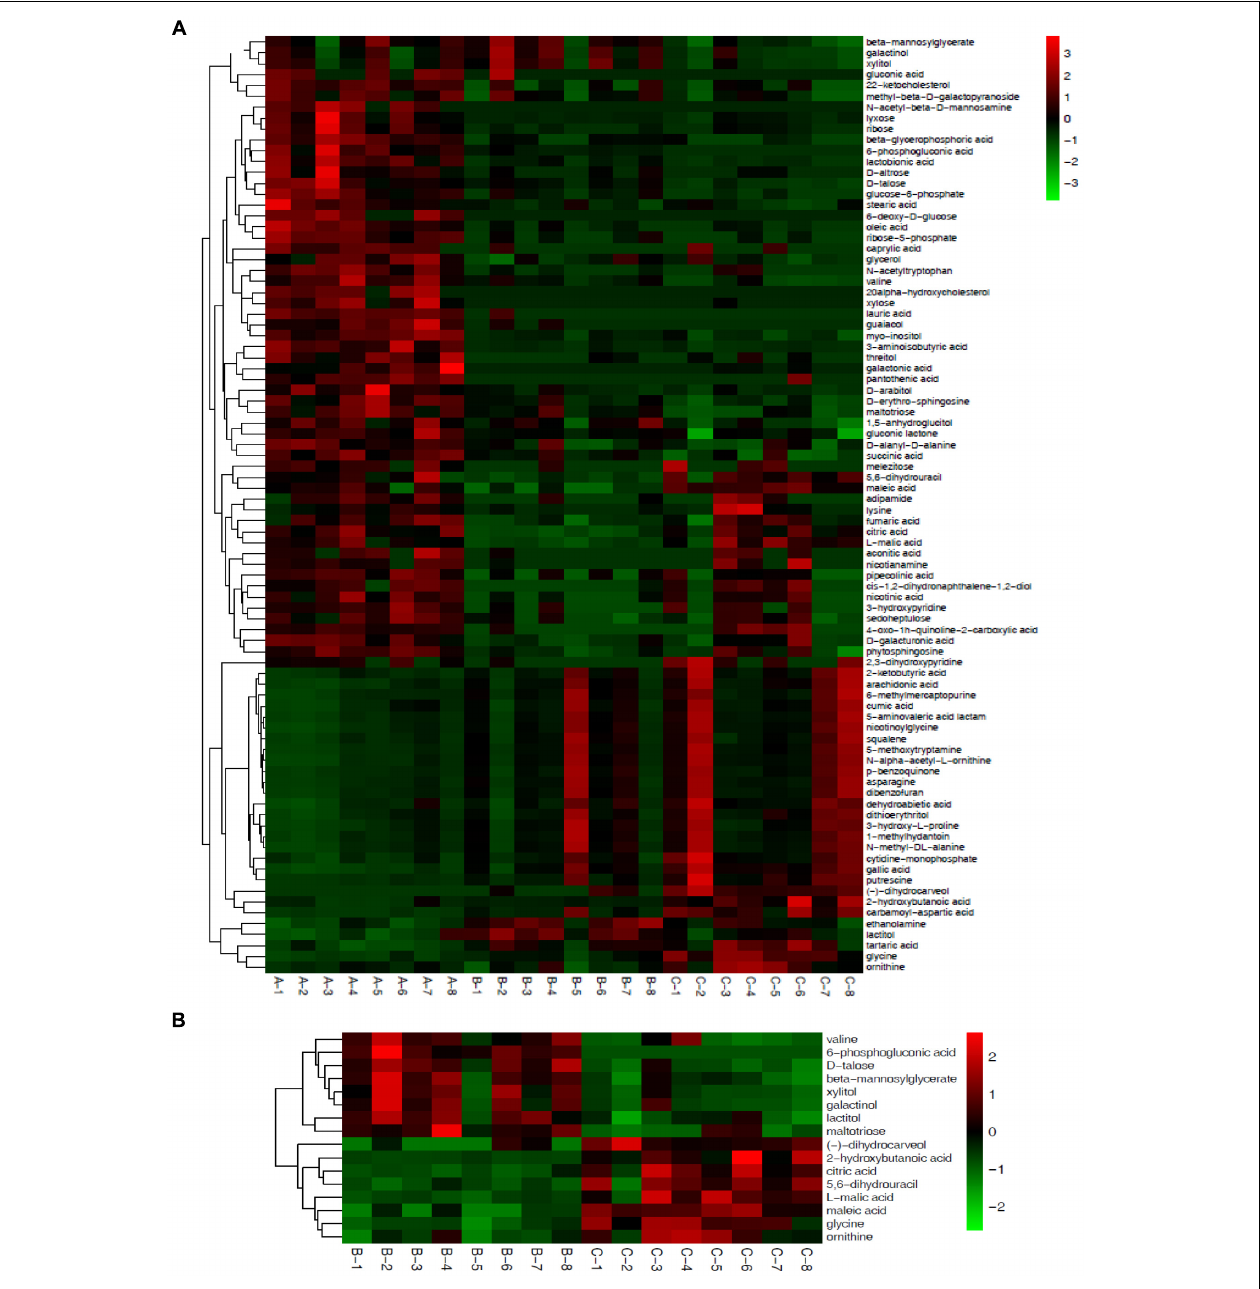
Table 4 . (A) Heat map visualization of differential metabolites among Mycelia A samples, Mycelia B samples and Mycelia C samples. (B) Heat map visualization of differential metabolites between Mycelia B samples and Mycelia C samples.